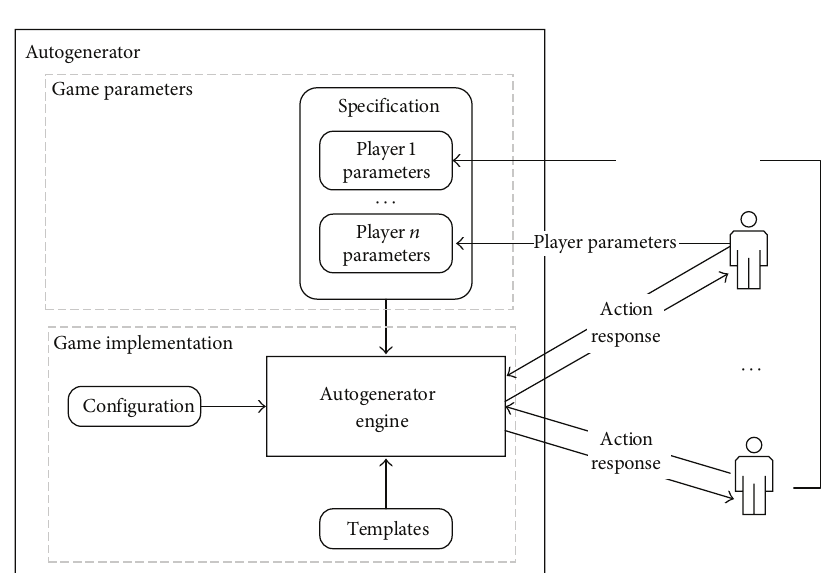
Figure 1: The autogeneration process.